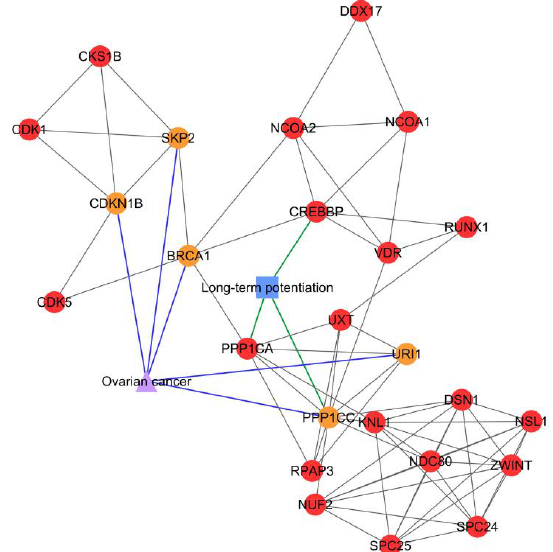
Figure 3. PCOS–disease subnetwork 8. This subnetwork showed shared proteins and shared pathway (long- term potentiation) between PCOS and ovarian cancer. Different coloring of nodes and lines represents PCOS-related proteins (red), shared proteins (orange), PCOS–disease interactions (blue), and protein– pathway interactions (green). Shape of nodes denotes PCOS-related proteins (circle), disease (triangle), and pathway (square).